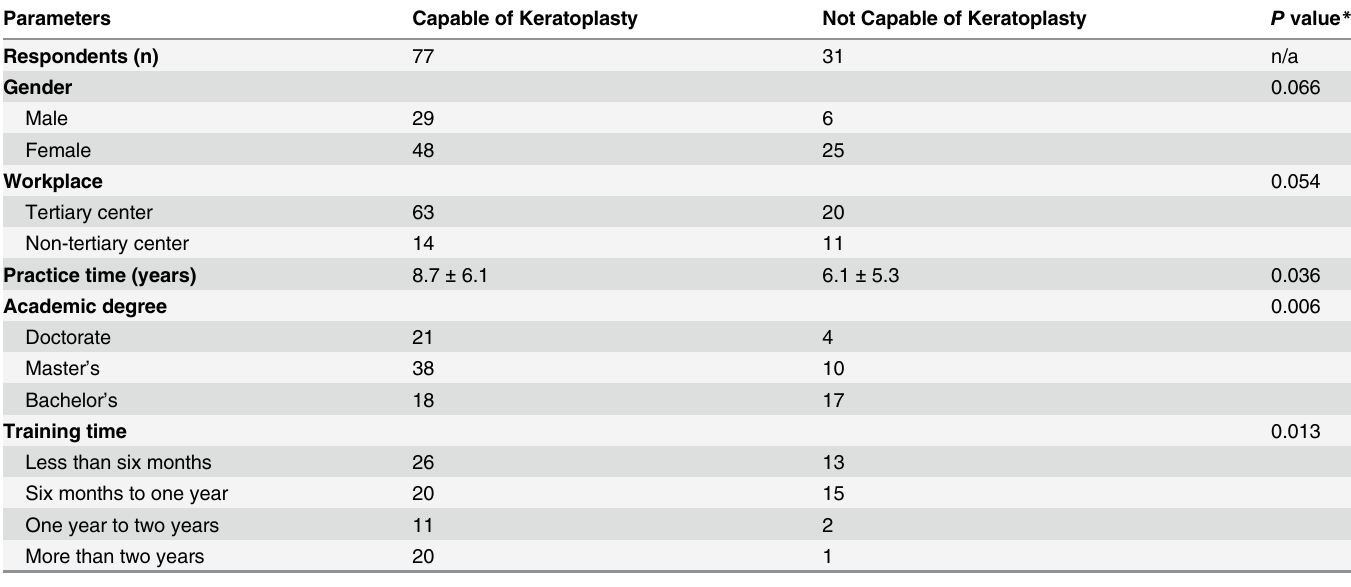
Table 2. Keratoplasty Experience among Chinese Corneal